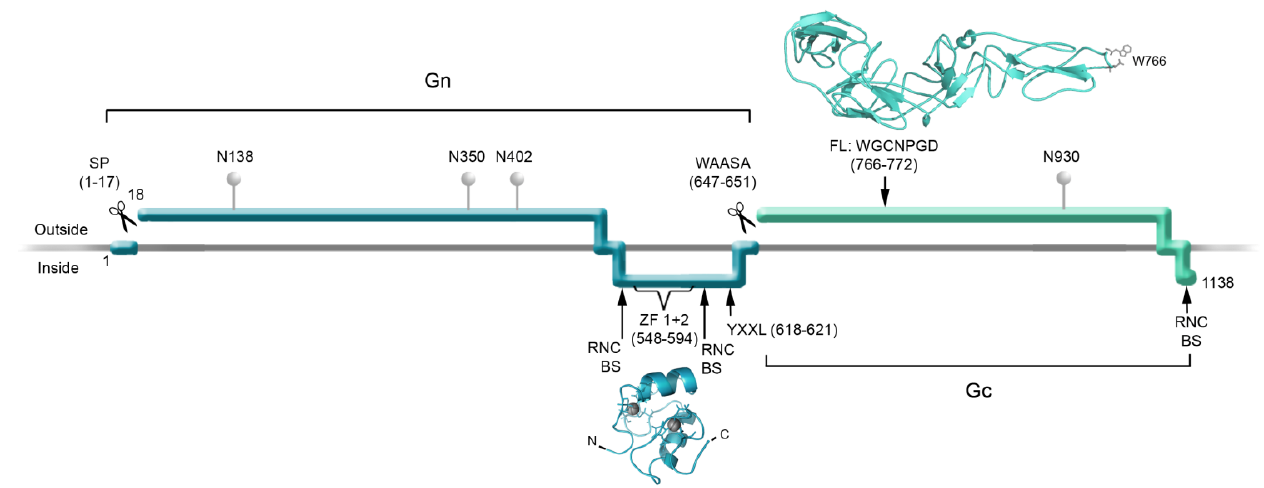
Figure 3. Schematic Representation of Hantavirus Glycoprotein Processing and Functions. The Gn (dark cyan) and Gc (light cyan) glycoprotein ectodomains, transmembrane regions and endodomains are represented according to their location relative to the membrane (horizontal grey line). The Signal peptide (SP) and WAASA sequences indicate the cleavage sites within GPC. N represents the location of asparagine residues that are likely to carry glycosylations; the numbers following these letters indicate the corresponding residue number within GPC of ANDV. ZF 1 + 2 indicates the location of the two zinc finger domains, RNC-BS indicates the suggested ribonucleocapsid binding sites. The motif YxxL represents residues involved in ubiquitination. FL indicates the location of the putative fusion loop of ANDV Gc. The molecular structure of the ANDV Gn-CT zinc finger domains (dark cyan) was obtained from the NCBI databank, PDBid: 2K9H [24]. The molecular model for the ANDV Gc fusion protein ectodomain was developed previously [29]. All ribbon diagrams of molecular structures were rendered in the PyMOL Molecular Graphics System